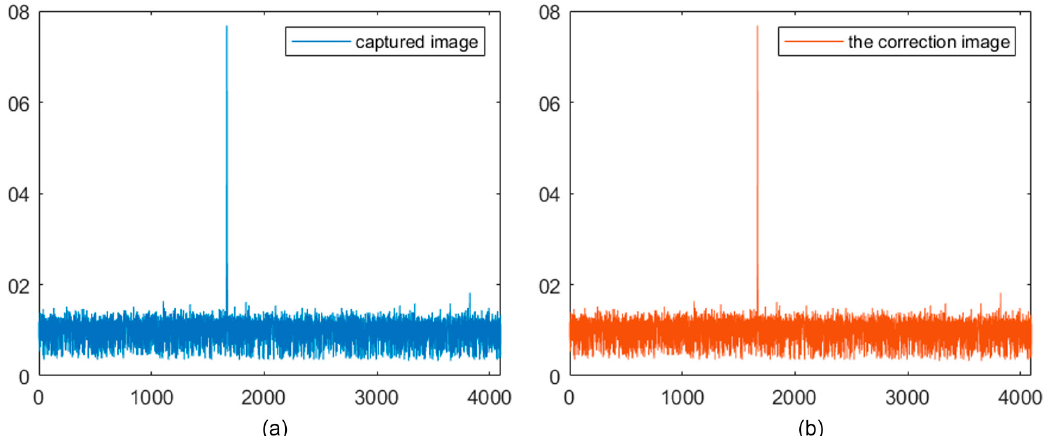
Figure 4. Comparison of the grey-level distribution on the same row in the ground truth image and corrected image. ( a ) ground truth image grey level distribution; ( b ) corrected image grey level distribution.